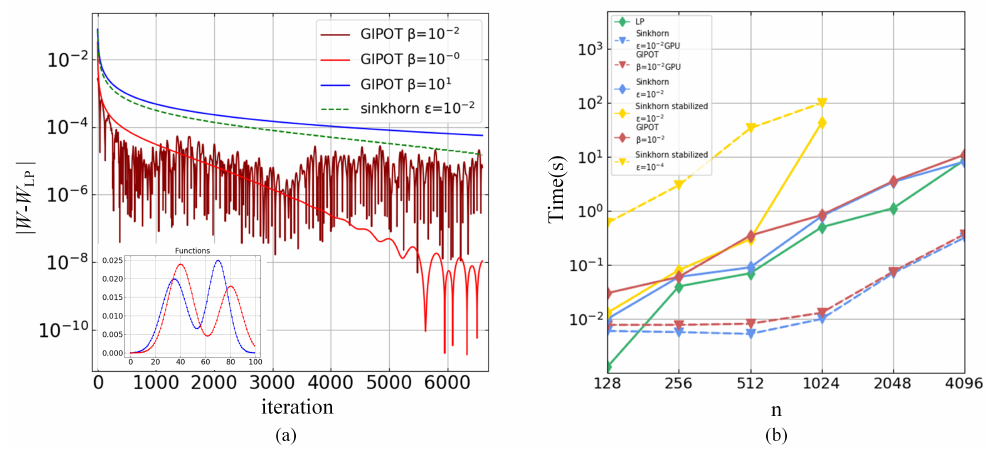
Figure 14. The difference graph of the Wasserstein distance. ( a ) GIPOT under different conditions and convergence trajectory graph. We also plotted the ones for the Sinkhorn method for comparison. ( b ) The average time of GIPOT and Sinkhorn iterations under different conditions.